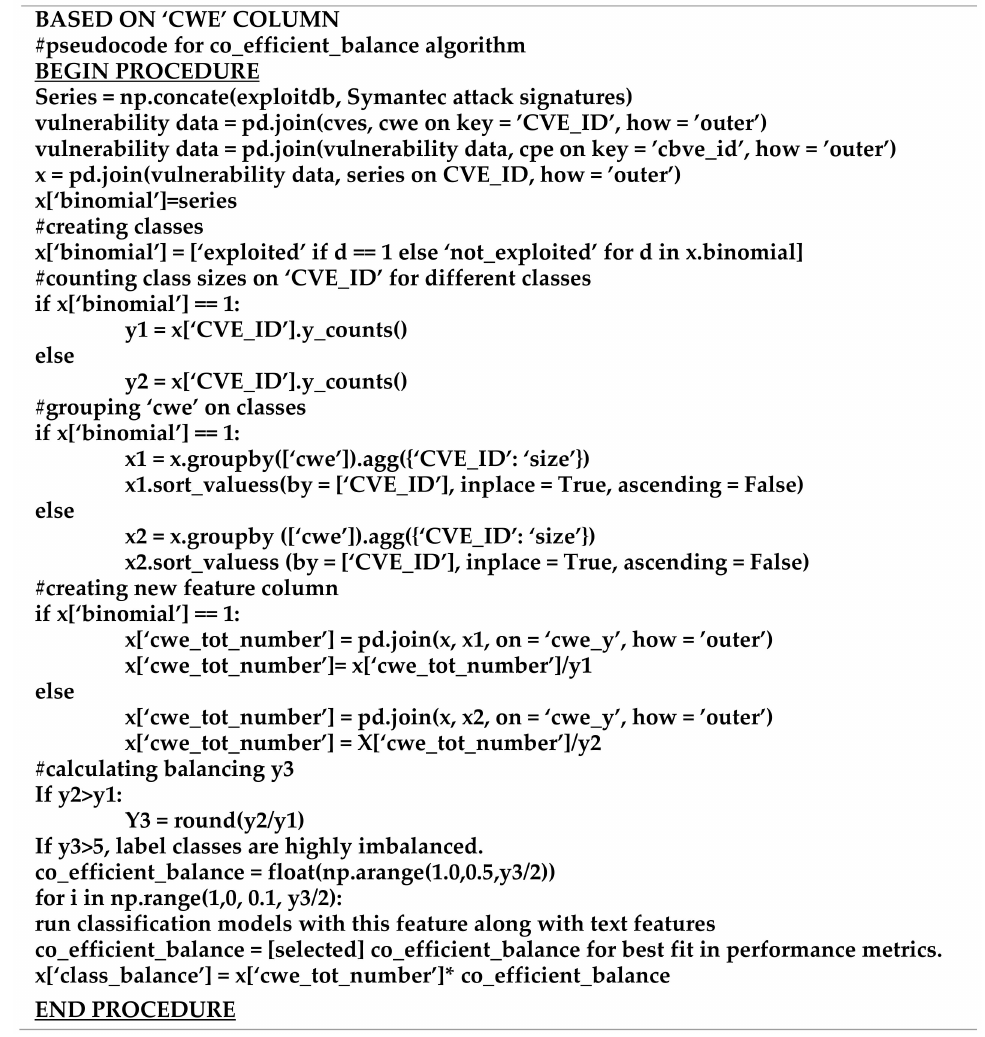
Figure 6. Algorithm (pseudocode) for the cost